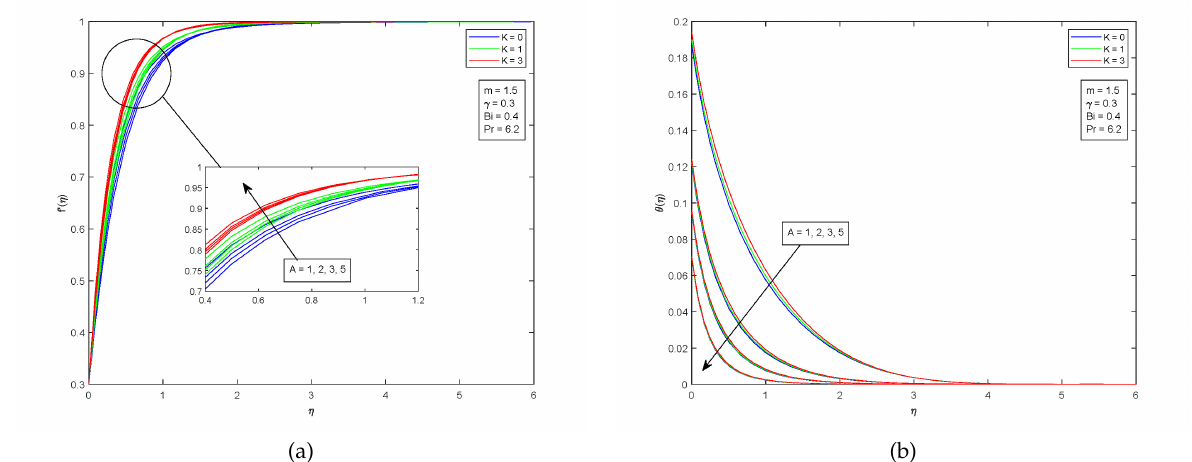
Fig. 2. The effect of A on velocity and temperature profiles for different values of K .